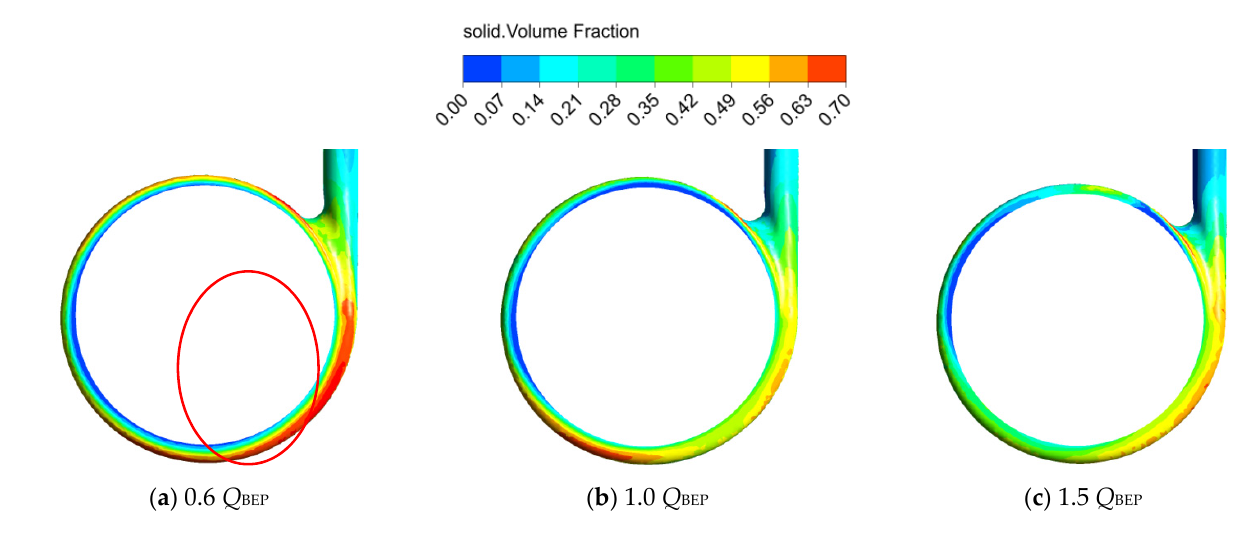
Figure 7. ( a – c ) Solid volume fraction distribution on the rear cover.